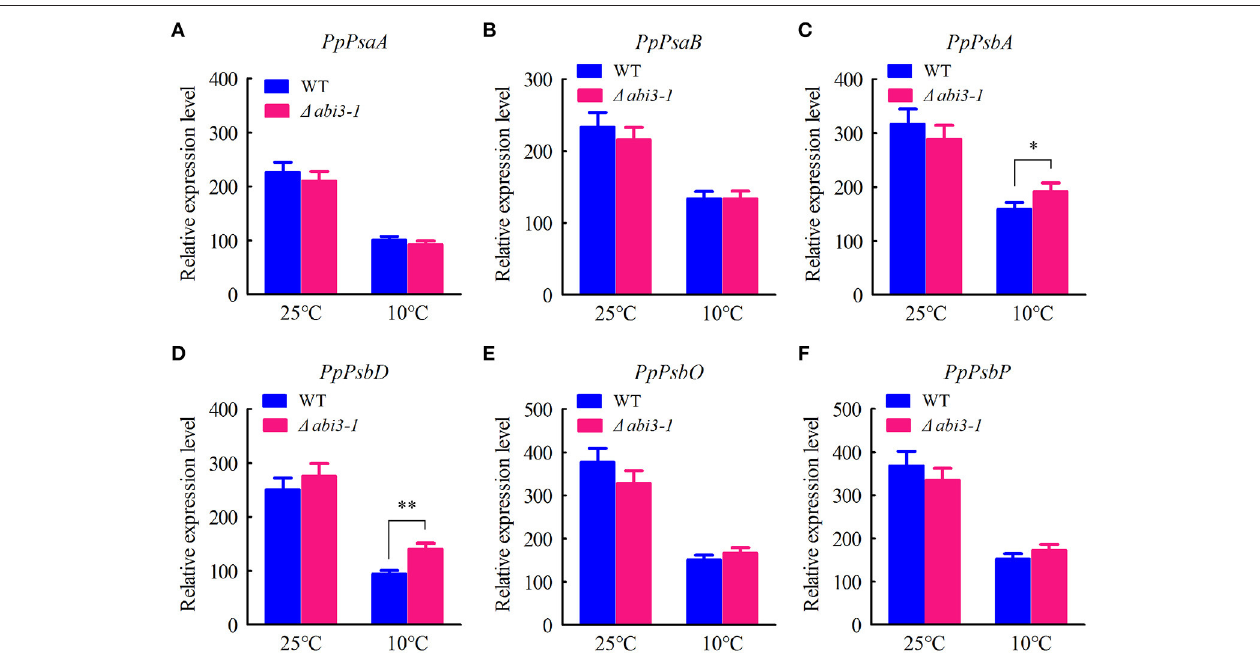
FIGURE 6 | Expression pattern of photosynthetic genes. (A–F) The transcriptional levels of genes related to photosystem manganese-stabilizing including PpPsaA (PhpapaCp039), PpPsaB (PhpapaCp040), PpPsbA (PhpapaCp046), PpPsbD (PhpapaCp044), PpPsbO (Pp1s60_65V6.1) and PpPsbP (Pp1s63_71V6.1) were determined by quantitative RT-PCR assay. Error bars represent SD ( n = 3), and two-way ANOVA was used to determine the statistical significance (* P < 0.05; ** P <